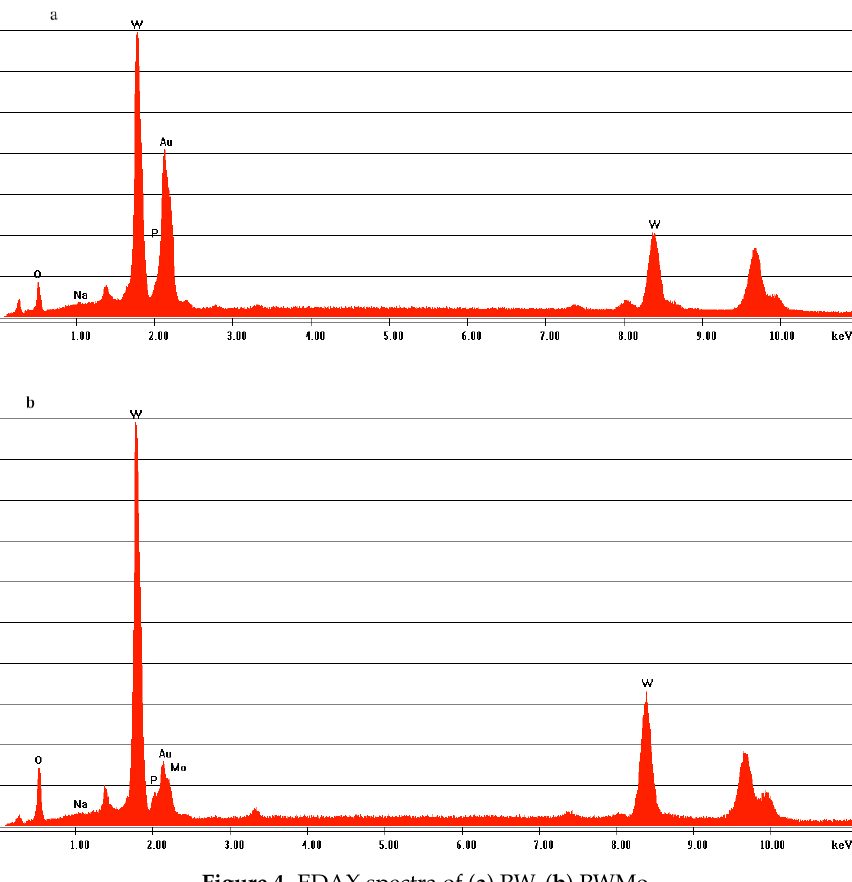
Figure 4. EDAX spectra of ( a ) PW, ( b ) PWMo.